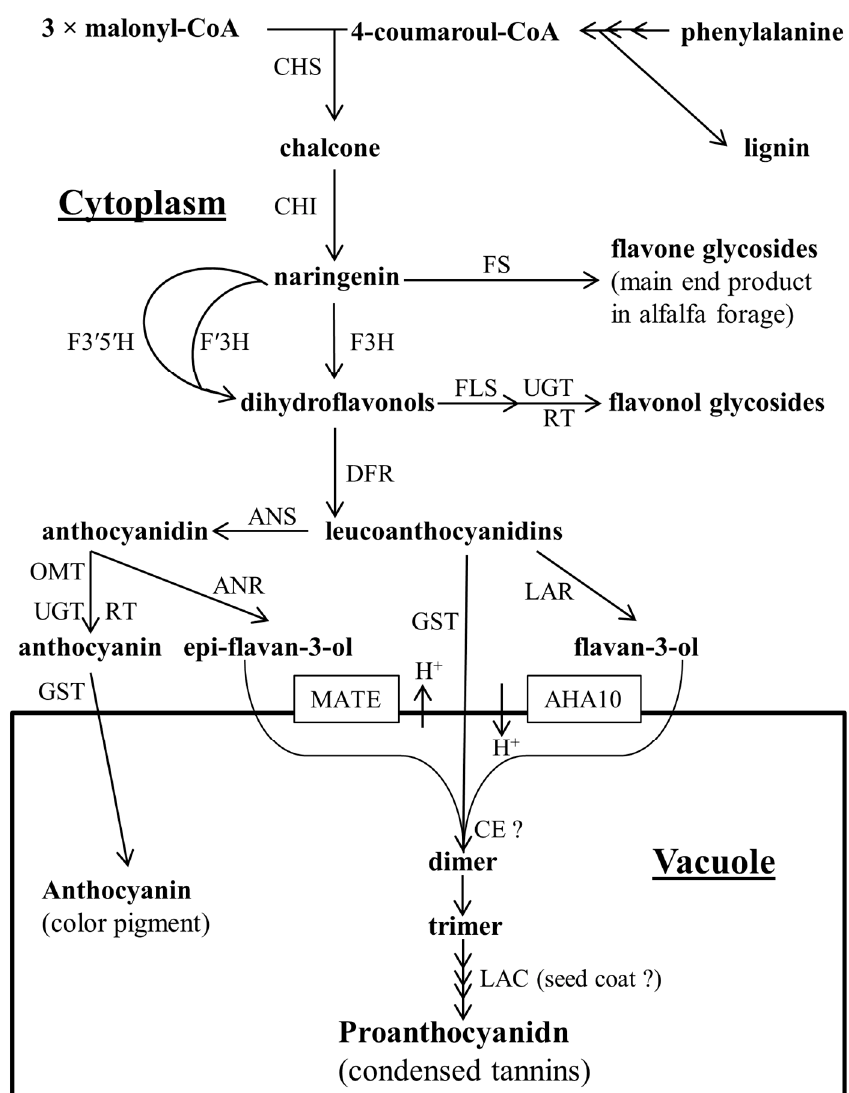
Figure 1. Biosynthetic pathway for anthocyanin and proanthocyanidin. Abbreviations for enzymes involved in the flavonoid pathway towards the synthesis of proanthocyanidin are as follows. CHS: chalcone synthase; CHI: chalcone isomerase; FS: flavone synthase; F3H: flavanone-3-hydroxylase; F ′ 3H: flavonoid 3 ′ hydroxylase; F3 ′ 5 ′ H: flavonoid 3 ′ 5 ′ hydroxylase; FLS: flavonoid synthase; UGT: UDP-dependent glucosyltransferase; RT: rhamnosyl transferase; DFR: dihydroflavonol 4-reductase; ANS: anthocyanidin synthase; ANR: anthocyanidin reductase; LAR: leucoanthocyanidin reductase; OMT: O -methyltransferase; GST: glutathione S transferase; MATE: multidrug and toxic compound extrusion-type transporter; AHA10: plasma membrane H + -ATPase; CE: condensing enzyme; and LAC: laccase-like flavonoid oxidase, ?: unknown. This figure was prepared with information obtained from Kleindt et al. [12] and Zhao et al. [13].